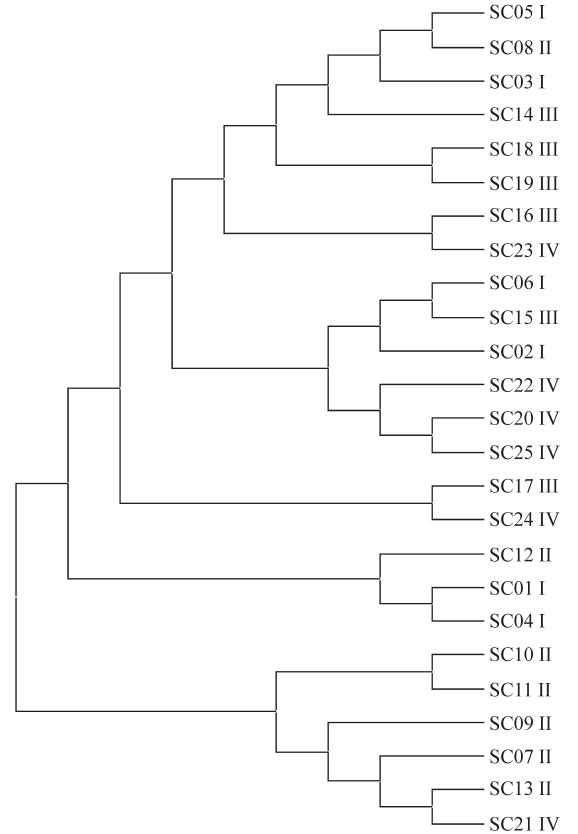
Figure 3 - Dendrogram of sugarcane phytocystatin expression pattern. Thetreewasconstructedusingtheunweightedpairgroupmethodwithav- erages (UPGMA) number of site differences and pairwise deletion. MEGA software was used for the